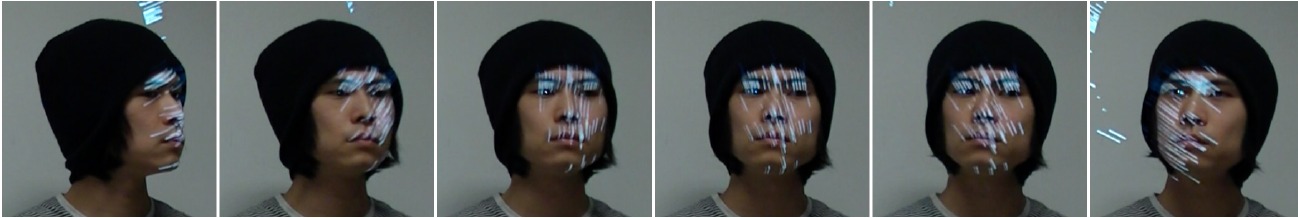
Fig. 8. Parallax rendering. The projected lines are visible through a mirror, and can be interpreted as parallel line segments extending from the